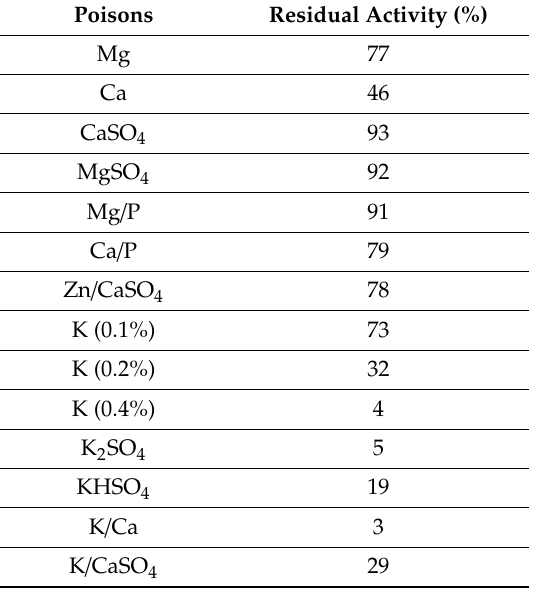
Table 3. The extent of deactivation of the V 2 O 5 -WO 3 / TiO 2 catalysts poisoned with 0.4 mol% (based on the sum of Ti, W and V) compounds reported in the first column (unless otherwise indicated) after calcination at 400 ◦ C 5h. Adapted from Reference